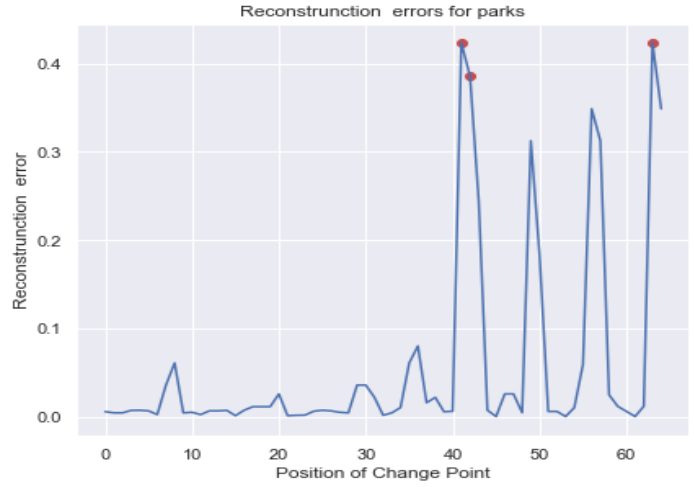
Figure 8. Reconstruction errors for parks. The horizontal axis shows the positions/locations of the change-points detected by the hybrid LSTMAE model. Thereafter, the detected change-points are matched with the exact dates of the interventions. 15 February 2020, corresponds to position 1 and 19 April 2020, corresponds to position 65. The change-points are shown as dots at the points where the reconstruction errors are highest. Figures 4 and 6–9 all contain the change-point detected at location 42 (27 March 2020). For grocery and pharmacy, the change-point was detected at location 41, i.e., a day before the start of the lockdown. The change-points at locations 41 and 42 coincided with the first major intervention, a full lockdown (lockdown Level 5) that was imposed by the government of South Africa on 27 March 2020. This shows that our hybrid model accurately detected a known intervention (change-point) on 27 March 2020. A comparison of the change-points that were detected by LSTMAE and KQE and the commonly used R packages namely: change-point, Bayesian change-point (bcp), strucchange (breakpoints), from 15 February 2020 to 19 April 2020 is shown in Table 1. Table 1. A comparison of the date of occurrence and location of the change-points that were detected by the